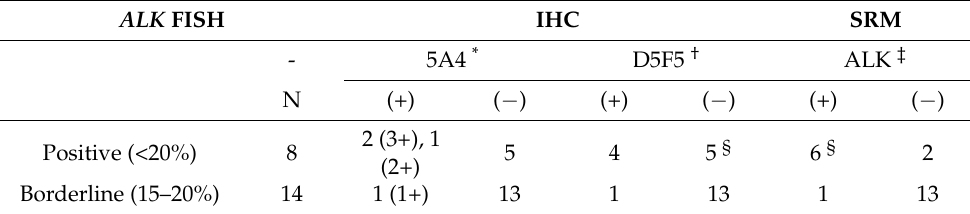
Table 2. Comparative analysis of ALK FISH, ALK IHC, and SRM of the 22 discordant